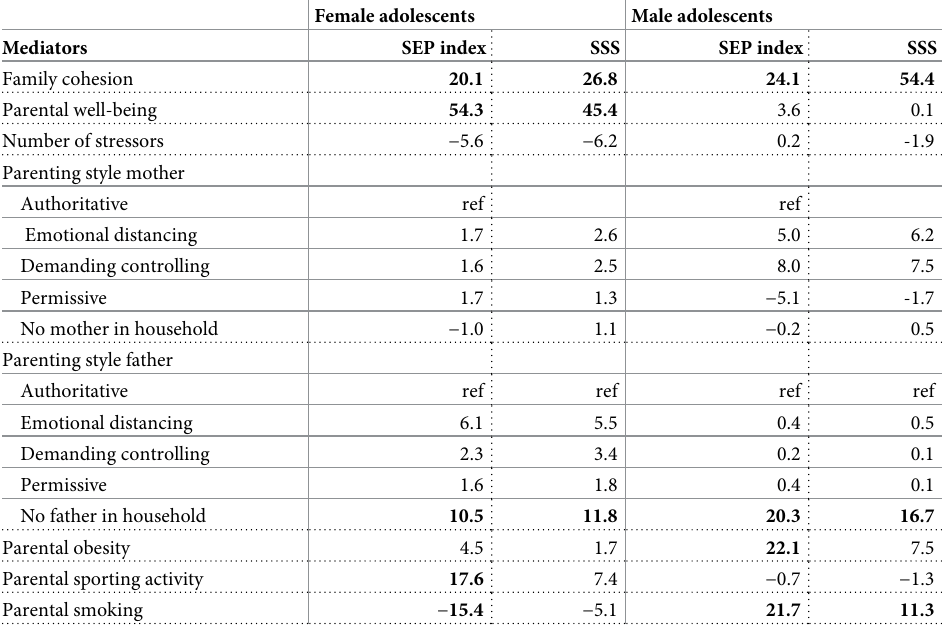
Table 3. Proportions (in %) of the indirect effect of the familial determinants in explaining the association of the SEP index and the SSS with SRH in female and male adolescents. Female adolescents Male